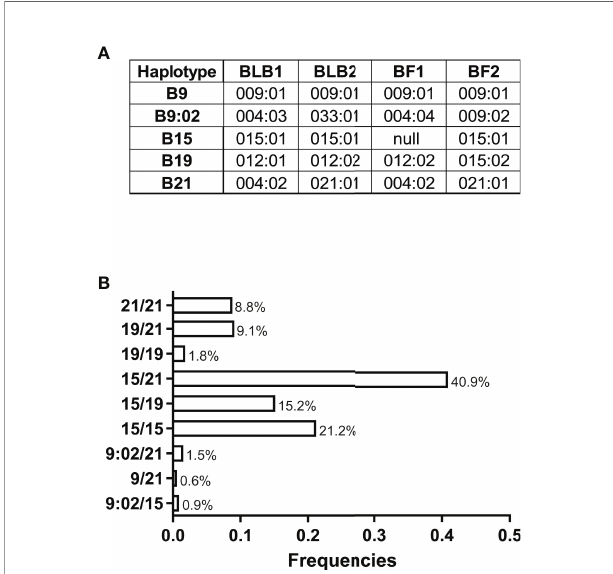
FIGURE 1 | (A) Alleles of BLB1, BLB2, BF1 and BF2 genes found as haplotypes in VALO SPF chickens, correlated with standard names of MHC haplotypes, except for B9:02 named after the BF2 allele, which is a variant of the BF2 allele in the standard B9 haplotype. (B) Frequency distribution of MHC haplotypes in these batches of VALO SPF chickens (n =